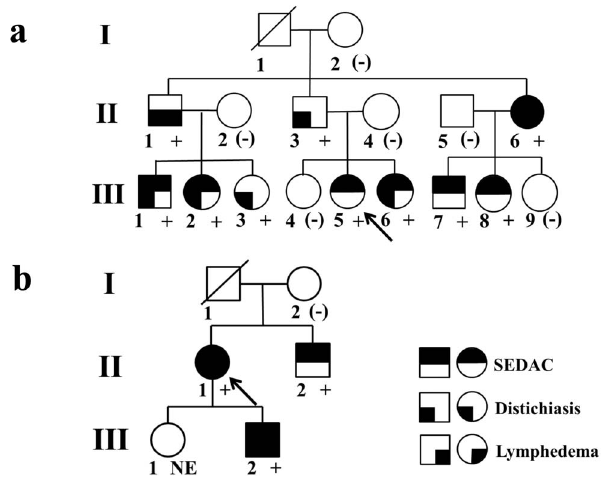
Figure 2. Pedigrees of the families with spinal extradural arachnoid cyst and co-segregation of the FOXC2 mutations. a) Family 1 with c.733delG, b) Family 2 with c.354C . G. Some family members had distichiasis and/or lymphedema. Autosomal dominant mode of inheritance is definite when the disorder of the pedigree was considered as a syndrome consisting of spinal extradural arachnoid cyst, distichiasis and lymphedema. All affected subjects of the syndrome had heterozygous c.733delG or c.354C . G mutation in FOXC2 . + and (-) indicate subjects with and without the mutations, respectively. NE indicates a subject who was not examined.